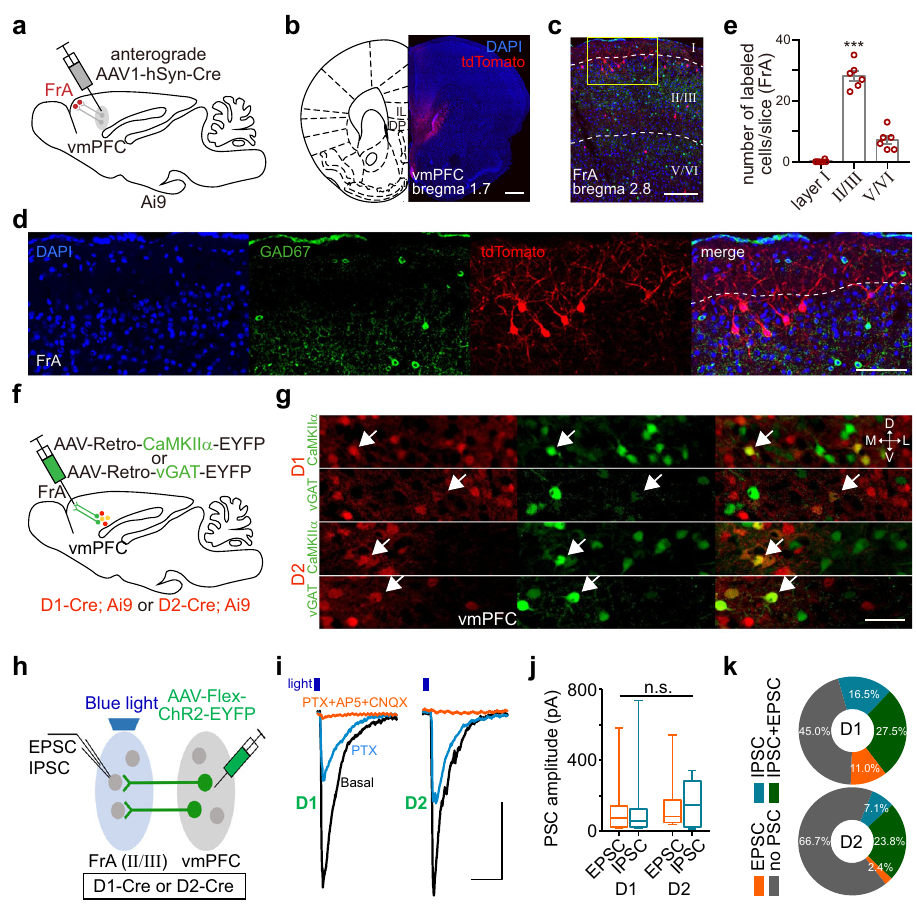
Fig. 5 | vmPFC – D1R and -D2R neurons synapse to the FrA. a Schematic of anterograde trans-monosynaptic virus (AAV1-hSyn-Cre) injection into the vmPFC (ILandDP)ofAi9micewithCre-dependenttdTomatoexpression. b Representative micrograph showing tdTomato expression in the vmPFC, repeated in three mice. Scale bar, 500 µ m. c , d Representative micrograph of anterogradely-labeled neu- rons (red) in the FrA with immuno fl uorescence for GAD67 (green). The boxed region is enlarged in ( d ). Scale bars, 200 µ m for ( c ), 100 µ m for ( d ). e Statistics (mean±s.e.m.) of anterogradely-labeled neurons in different layers of the FrA. n =6 slices from three mice. Comparisons between layers II/III and layers I or V/VI were analyzed with one-way ANOVA followed by Dunnett ’ s multiple comparisons: F (1.606,8.032)=201.2, p <0.001;multiplecomparisons: p <0.0001. f , g Schematic and representative micrographs showing retrogradevirus injection into the FrA of D1/D2-Cre and Ai9-crossed mice. White arrows indicate the retrograde virus- labeled D1R- or D2R-positive (red) glutamatergic or GABAergic neurons in the